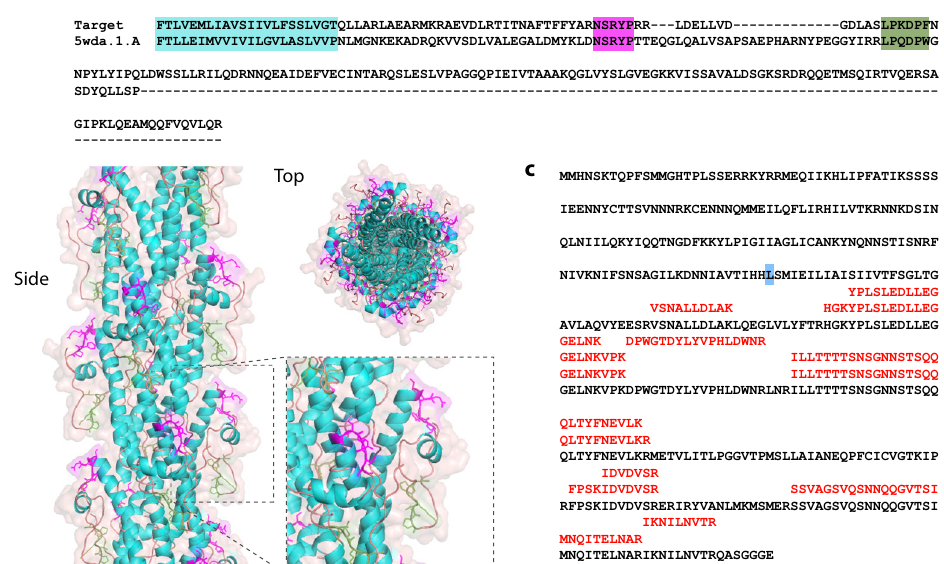
Fig. 6 Structure and maturation of mitochondrial GspG. a Domain architecture of the bacterial and the mitochondrial pseudopilin GspG (top). The arrow indicates the processing site of the bacterial GspG during protein maturation. MTS mitochondria targeting sequence, + polar anchor, TMD transmembrane domain, ND novel domain. (Bottom) Protein sequence alignment of the pseudopilin domains of mitochondrial and bacterial GspG proteins (in case two paralogues are present, only GspG1 is shown). b Homology modelling of Go GspG1. Top: pairwise alignment of protein sequences of Go GspG1 and Klebisella oxytoca PulG (the template used in model building). Regions of high sequence similarity are highlighted, including the hydrophobic segment (cyan), the α - β loop (magenta) and GspG signature loop with conserved Pro residues (green). Bottom: side and top views of the cartoon and transparent surface representation of Go GspG pilus model based on the pseudopilus cryo-EM reconstruction 46 . Proteins are coloured based on the secondary structure, with helix regions in cyan and loops in light brown. The regions of GspG1 sharing high similarity with PulG are highlighted with the same colour code as in the sequence alignment, with side chains shown in magenta and green. Inset: detail of the structurally conserved loop regions. The novel domain (ND) speci fi c to mitochondrial GspG proteins was omitted from the modelling. c Peptides speci fi c to Ng GspG1 retrieved from the proteomic analysis of N. gruberi mitochondria. The Leu residue highlighted in blue indicates residue + 1 following the processing site of bacterial GspG